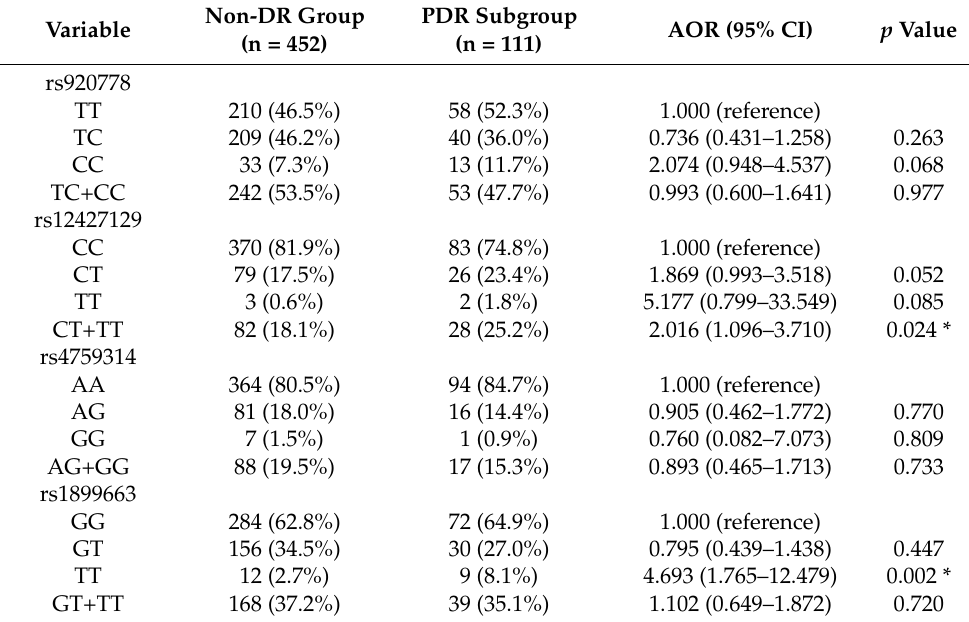
Table 4. Odds ratio and 95% confidence interval of proliferative diabetic retinopathy associated with HOTAIR genotypic